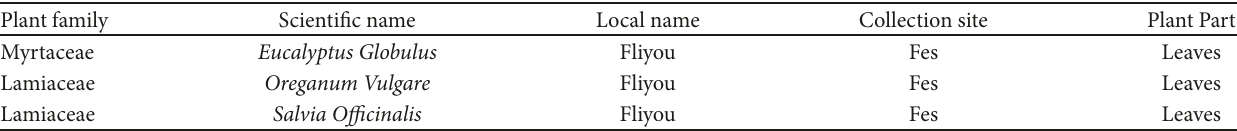
Table 1: Plant species used in the experiment for EOs